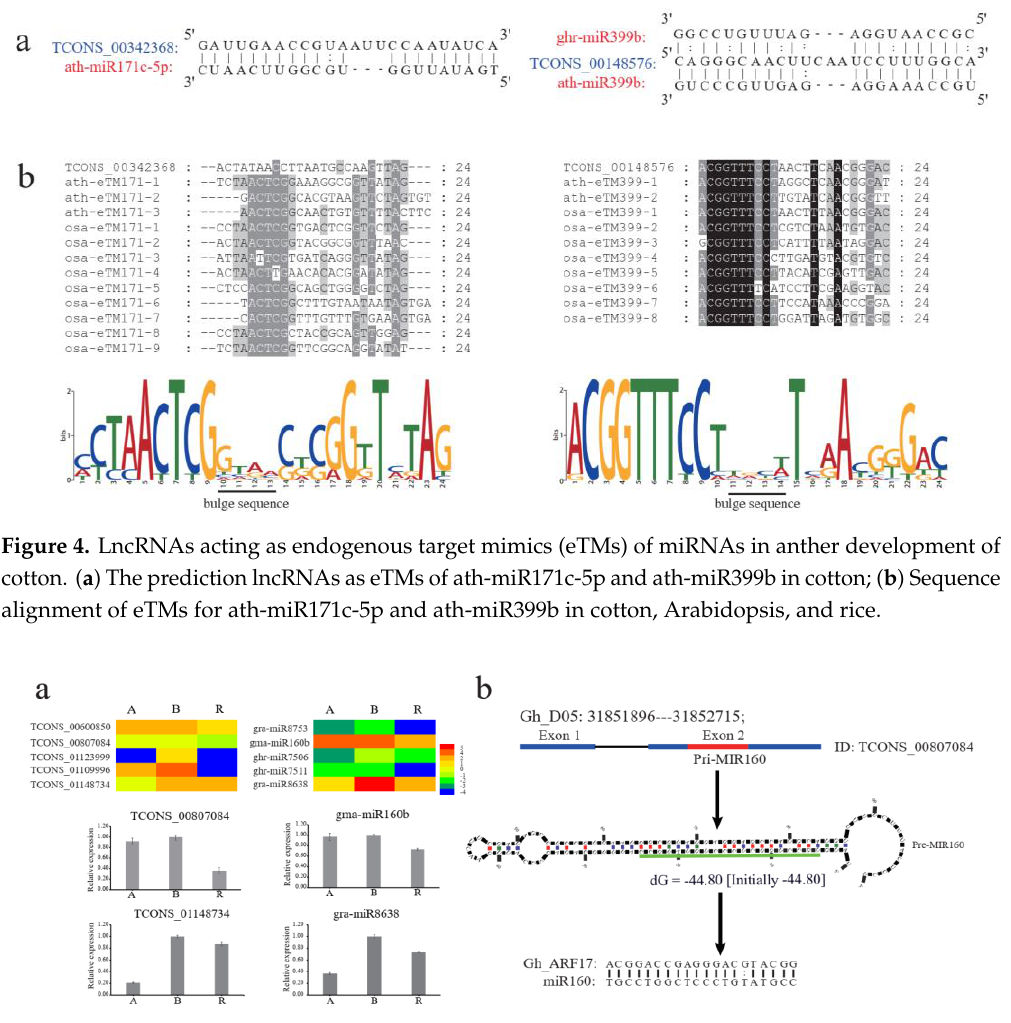
Figure 5. Expression and functional prediction of lncRNAs generating corresponding miRNAs. ( a ) RNA-seq and qRT-PCR validate the expression level of miRNAs precursor lncRNAs; ( b ) The module of lncRNAs generating corresponding gma-miR160b to regulate target gene. The red line in exon 2 is the miR160 precursor. The green line is the mature sequence of miR160.